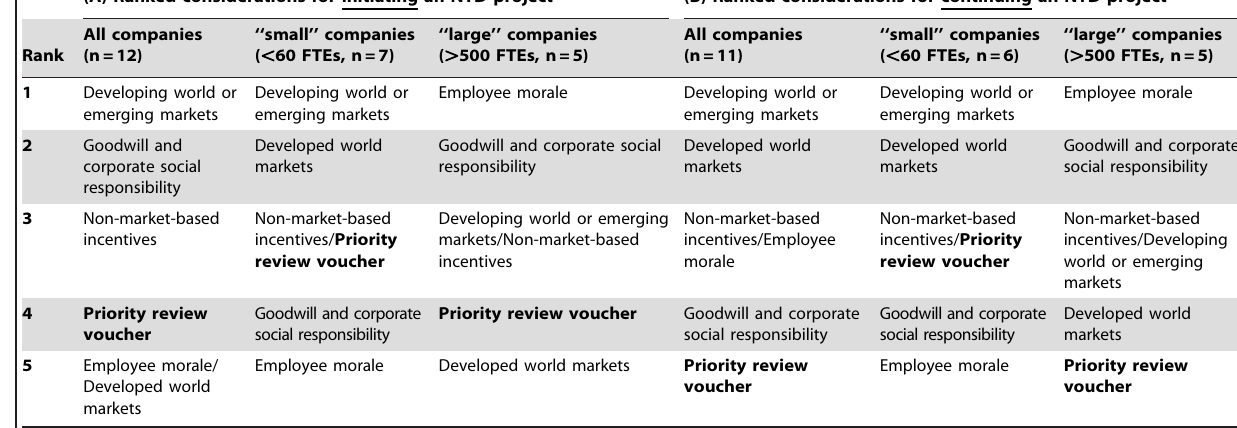
Table 1. Ranked considerations for initiating and continuing a neglected tropical disease (NTD)